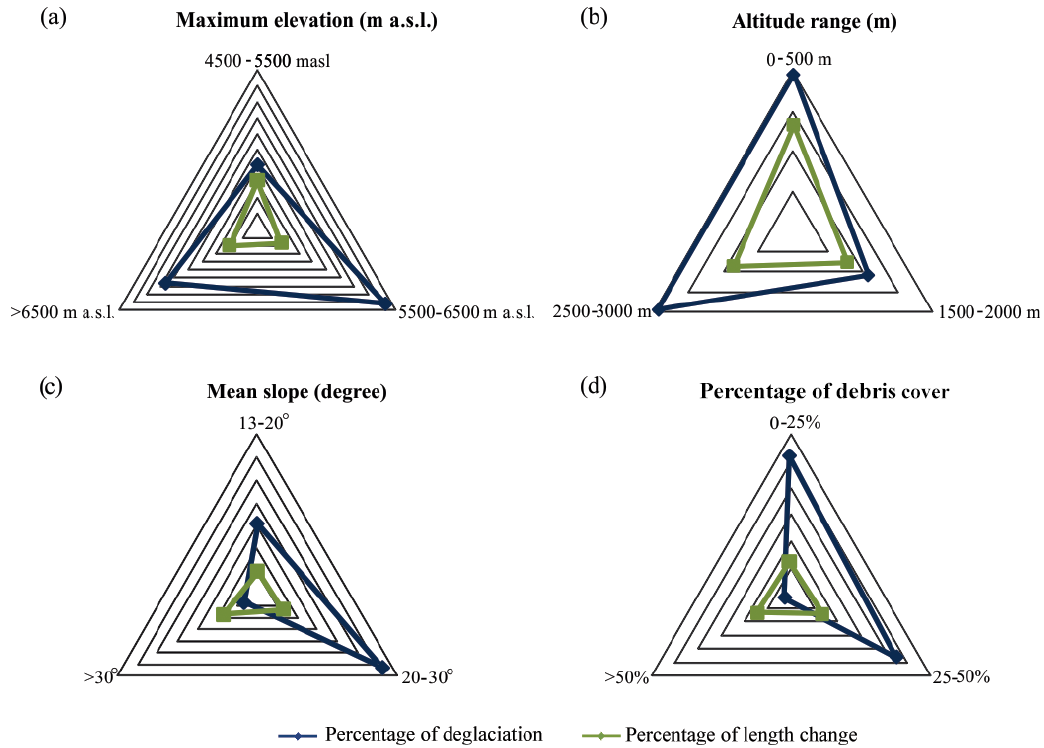
Figure 10. Differential degeneration of the glaciers during the period 1971–2017 with variability in non-climatic factors. (a) Percentage of deglaciation and length change of the glaciers at different ranges of maximum elevation, (b) altitude range, (c) mean slope and (d) percentage of debris